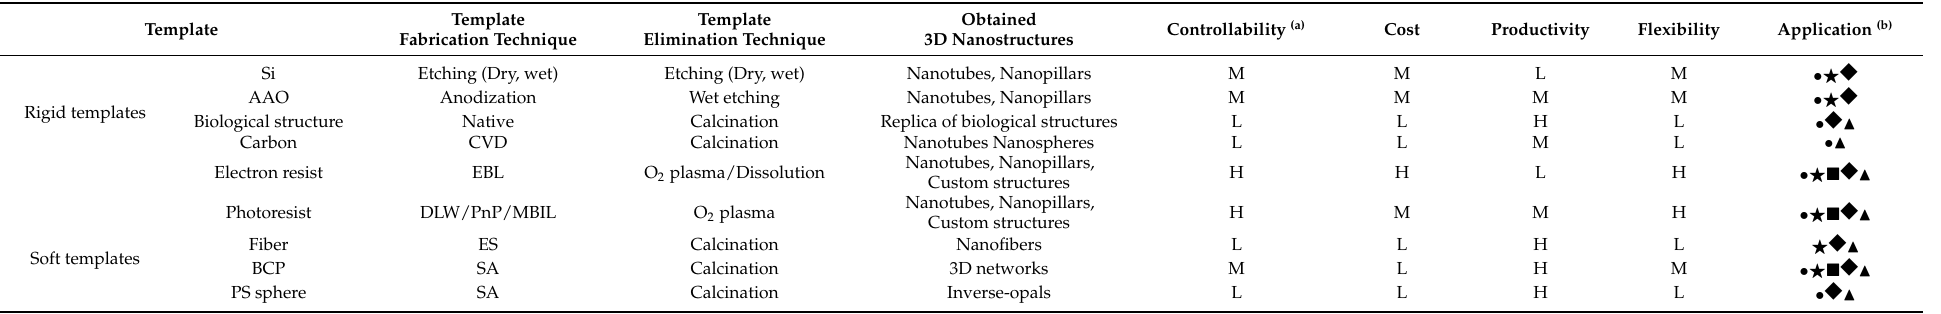
Table 1. Comparison of nanostructures based on rigid and soft templates. (a) L = low, M = medium, H = high; (b) ● Optical devices, ★ Electronic devices, ■ Engineering devices, ◆ Sensing devices, ▲ Catalytic device.